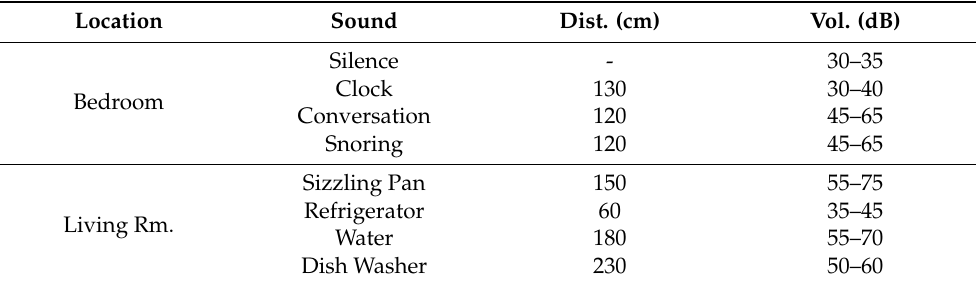
Figure 7. Test rooms and equipment configuration: ( a ) Bedroom (for false negative test). ( b ) Living room (for false positive test near refrigerator). Table 4. Non-mosquito sound clips for the false positive test; “Silence”: mixed sounds from outside and silence in